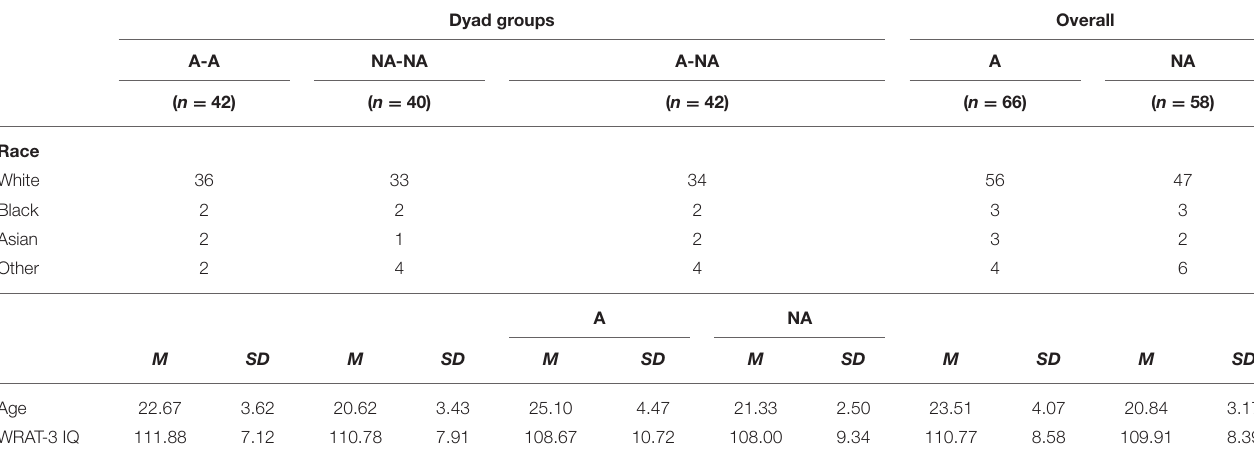
TABLE 1 | Demographic characteristics for diagnostic and dyad